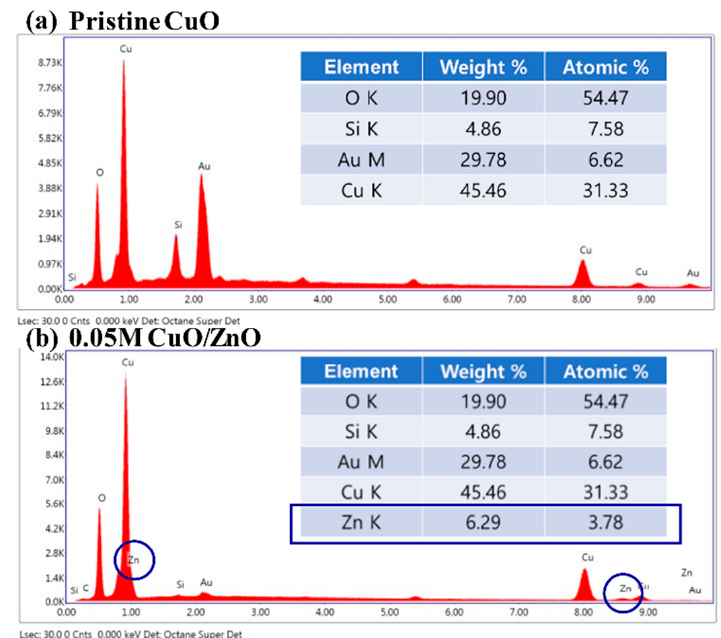
Figure 2. EDS analysis of ( a ) the pristine CuO, and ( b ) the 0.05 M CuO/ZnO.